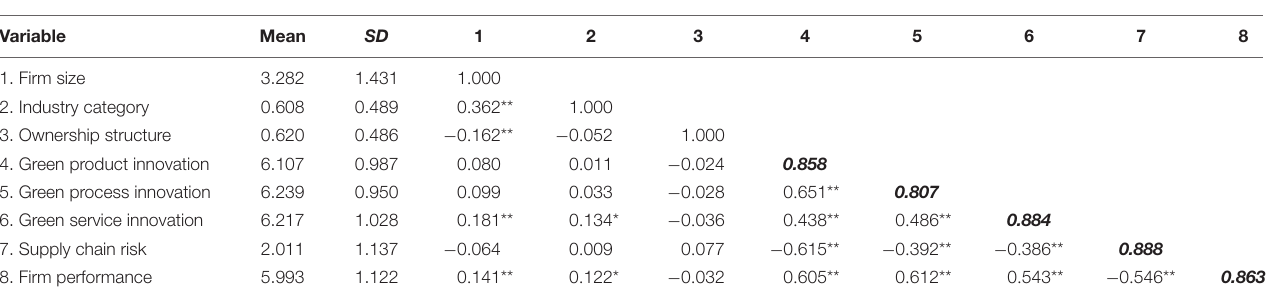
TABLE 2 | Descriptive statistics and correlations.